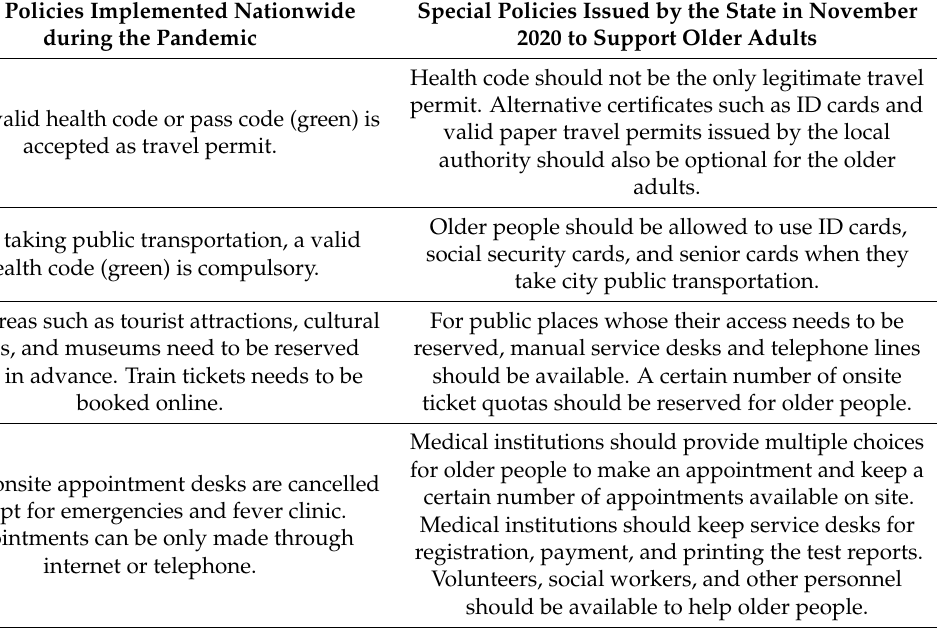
Table 2. Summary of Governmental Policies Regarding Three